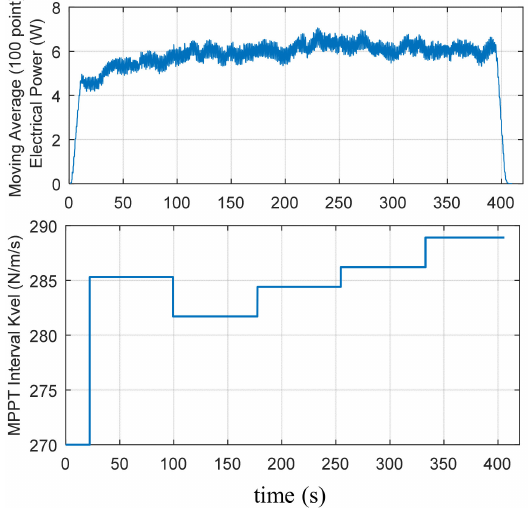
Figure 20. ‘Cycling’ MPPT with damping control. 0.75 Hz, 0.25 m peak-to-peak regular sea run for seven minutes. The upper plot shows the 100-point moving average for electrical power, the lower plot shows the damping coefficient value, updated approximately every